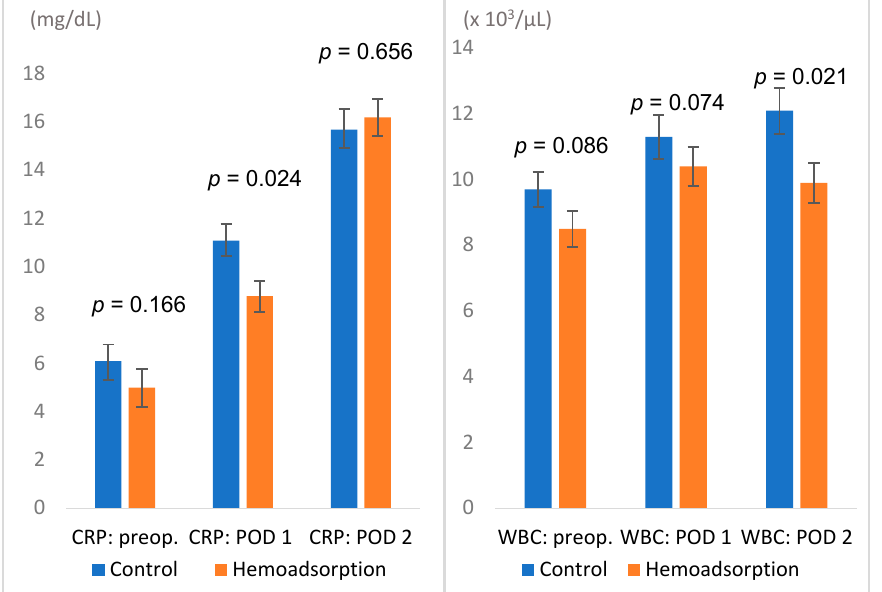
Figure 1. Sepsis, sepsis-associated mortality, and in-hospital mortality (propensity-matched co- hort).